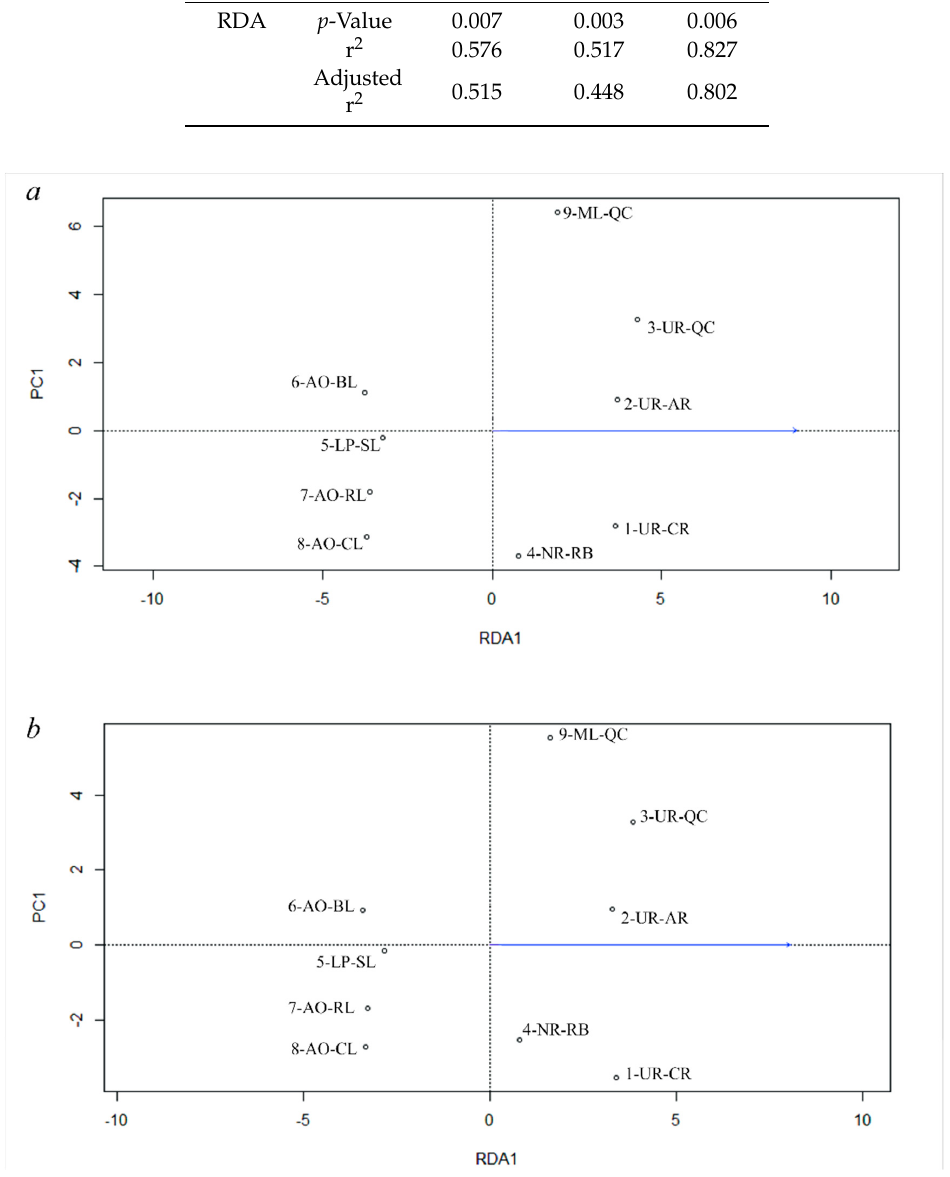
Table 7. Redundancy analyses (RDA) results for Total, Neutral and Outlier datasets in nine locality samples of Rhamdia quelen .